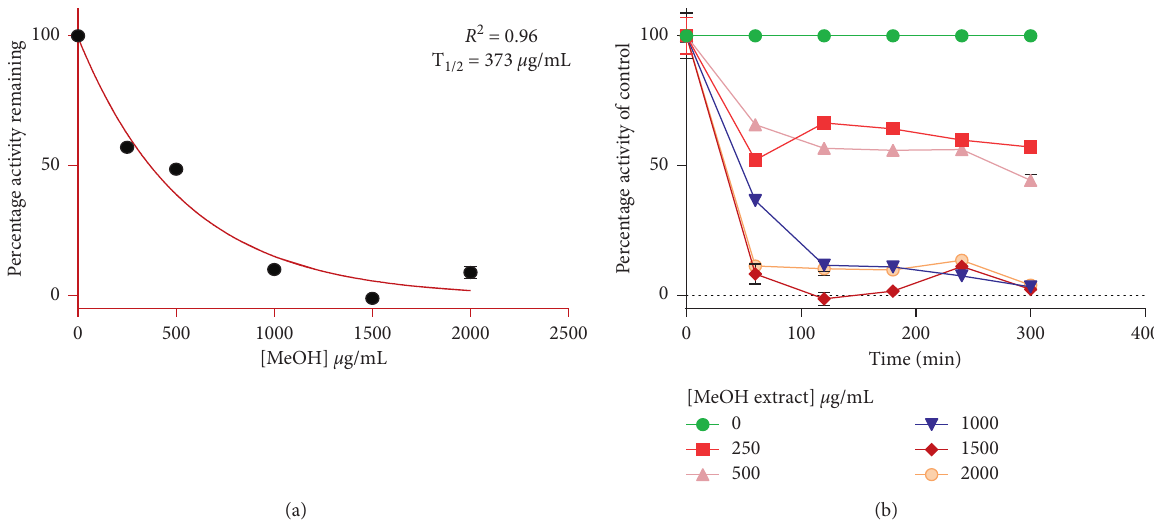
Figure 4: The effects of increasing the concentration of the methanolic (MeOH) extract from P. americana on the activity of α -glucosidase enzyme over time (a) and the concentration-dependent effects of the methanol extracts (b).